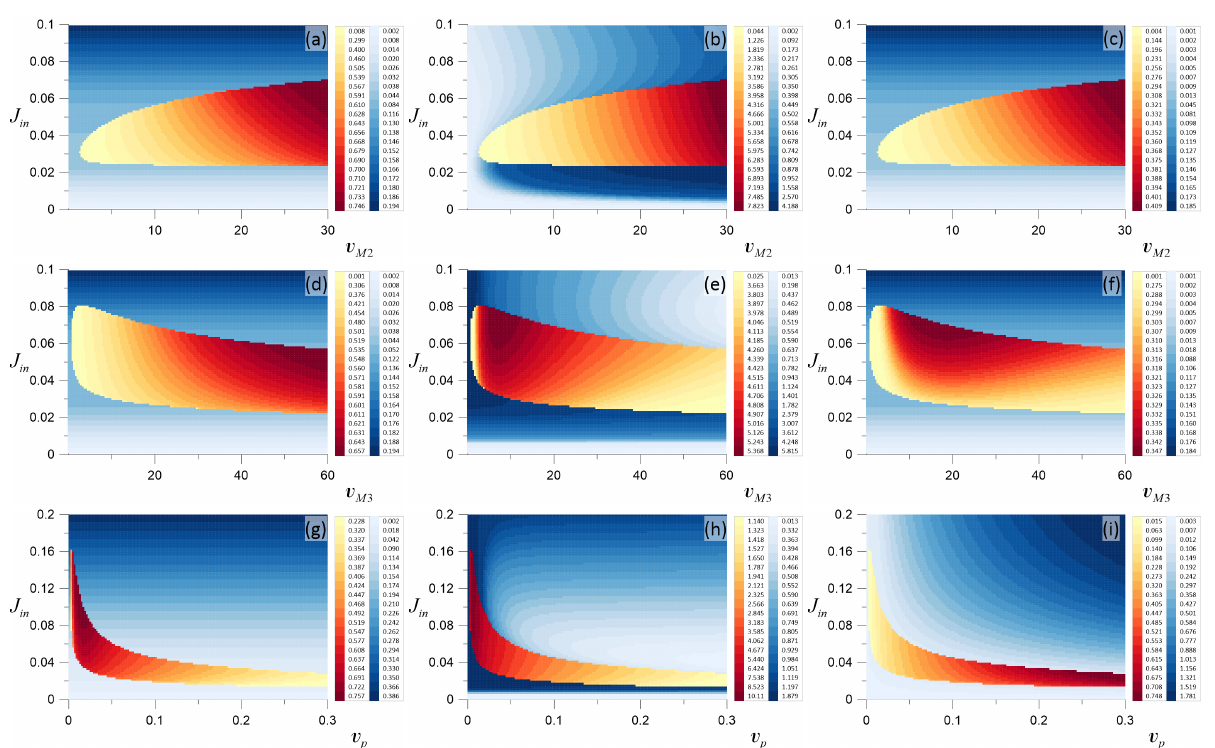
Figure 3. Two-parametric diagrams obtained for three variables of the system (1), namely, for [ Ca 2 + ] cyt ( a , d , g ); [ Ca 2 + ] [ IP ] cyt ( c , f , i ); and for ( a – c )—( v ER ( b , e , h ); and M 2 , J in ) parameter space; ( d – f )— 3 ( v M 3 , J in ) and ( g – i )—( v p , J in ) space. Domains shown in blue correspond to steady state solution. The intensity of the color demonstrates the change of the corresponding variable in equilibrium. The difference between the minimal and the maximal value of the corresponding variable in the oscillatory regime is shown by the red-to-yellow